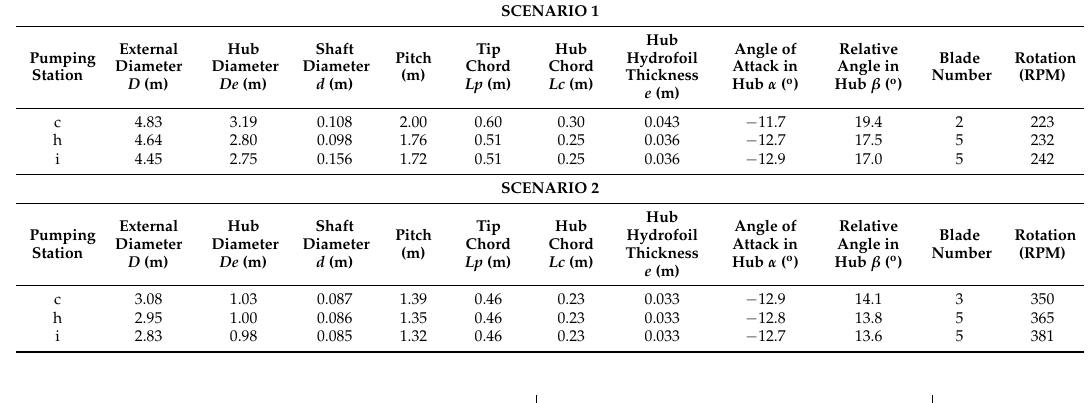
Table 9. Dimensions of the axial pumps for underwater pipeline Huanghe/Dalian-China. Scenario 1 (200 L/capita/day), Scenario 2 (81 L/capita/day).